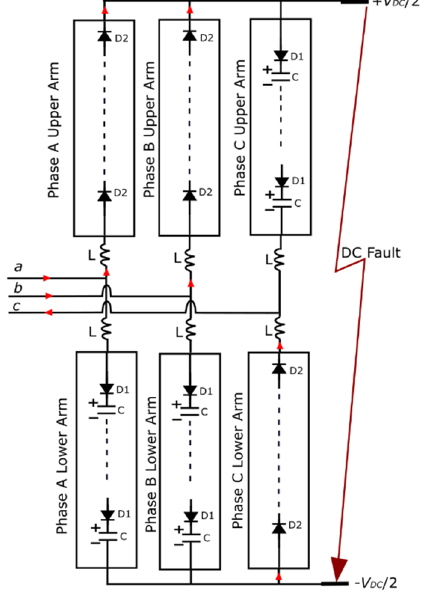
Figure 5. Fault current path in HBSM-MMC during pole-to-pole fault.